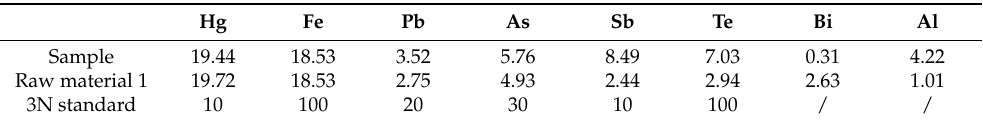
Figure 4. Diagram of the effect of density on impurity separation: ( a ) diagram of the static experiment; ( b ) photograph of the static experiment. Table 4. Sample compositions of static experiment (units: ppm).